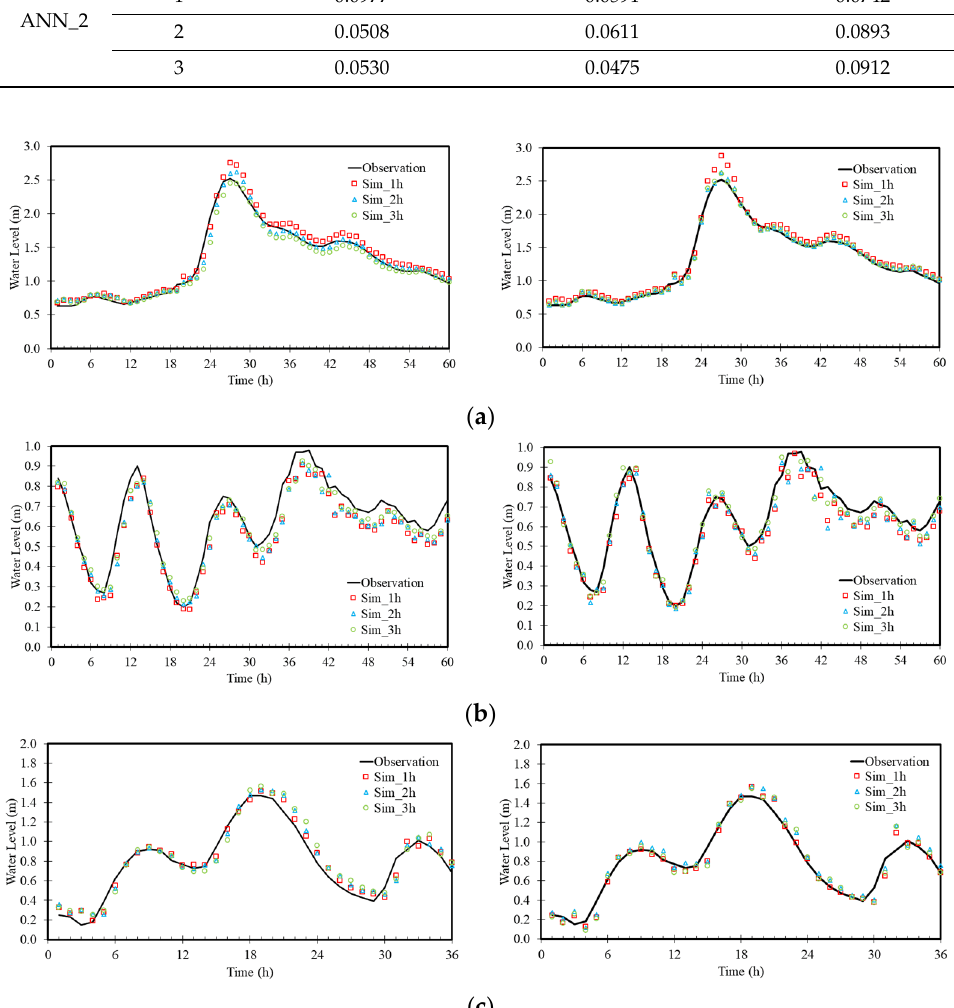
Figure 9. Comparison of simulated and observed water levels at YR_R2 for the ANN_1 model ( left ) and ANN_2 model ( right ) at Yutu ( a ), Mangkut ( b ), and Maria ( c ).